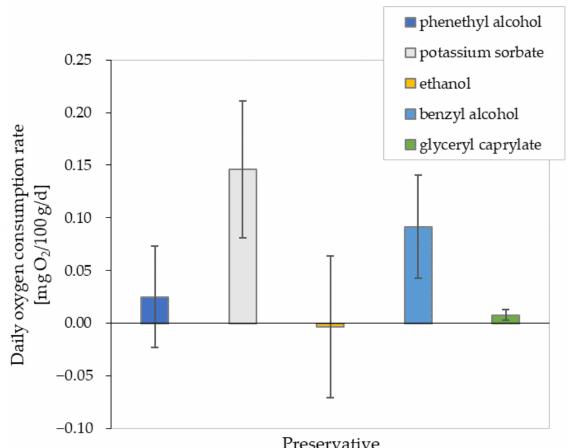
Figure 3. Daily oxygen consumption rate (mean ± standard deviation) (mg O 2 /100 g/d) with different preservatives, calculated from the oxygen uptake measured over a storage time of 96 days at 30 ◦ C under light